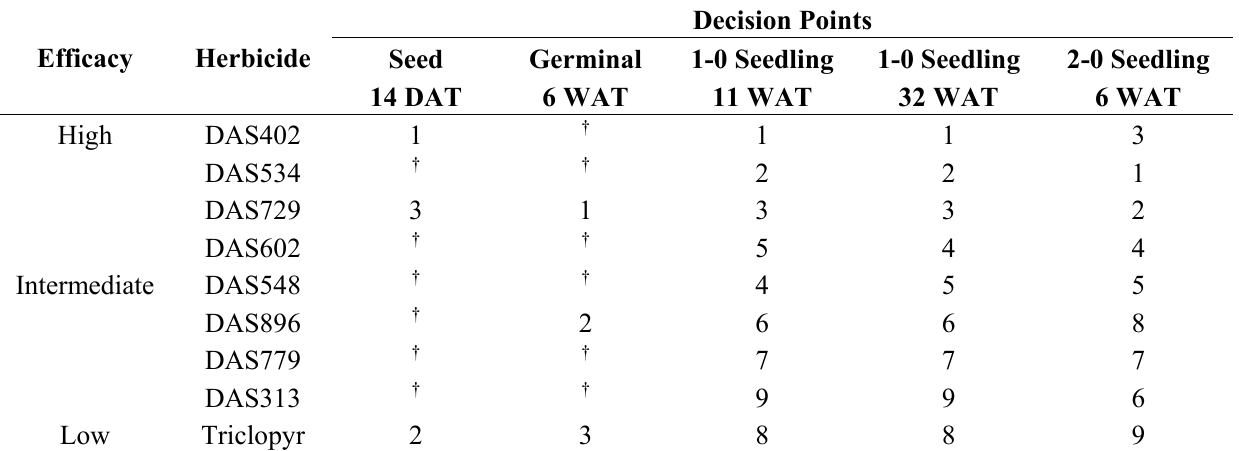
Table 7. Overview of herbicide rankings ‡ across screening types for loblolly